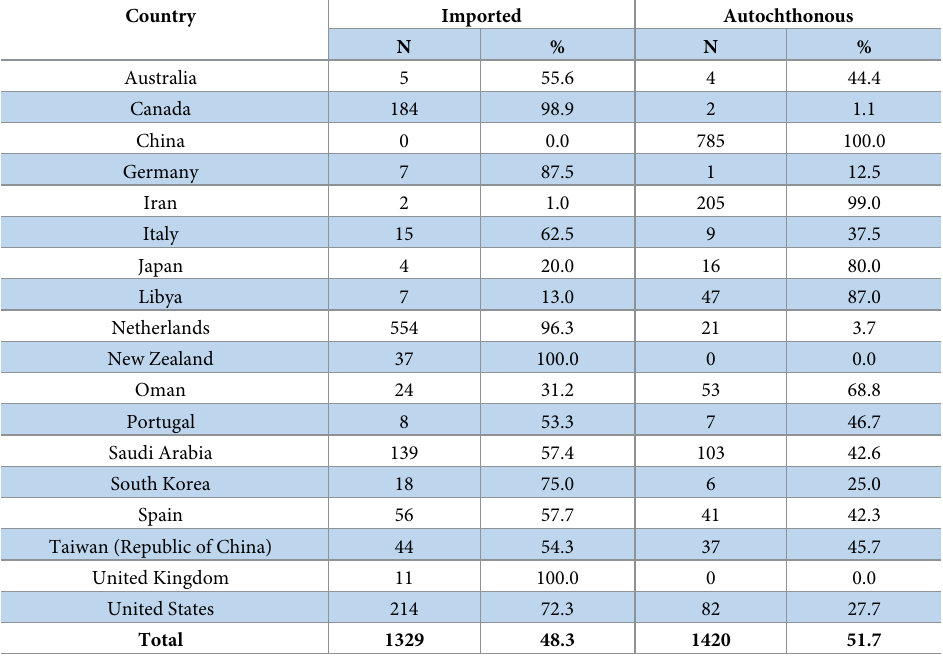
Table 5. Suspected imported and autochthonous cases reported.